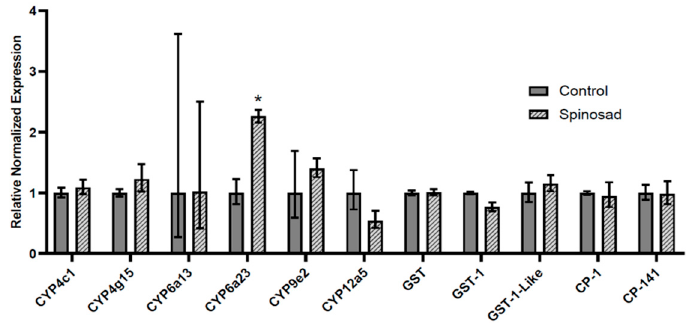
Figure 4. Expression of transcript levels, normalized to RP-18 , in spinosad-treated versus untreated insects. Data are mean standardized transcript levels (mean ± SEM, n = 4–5). Asterisks represent results significantly different from control samples (* p < 0.05).